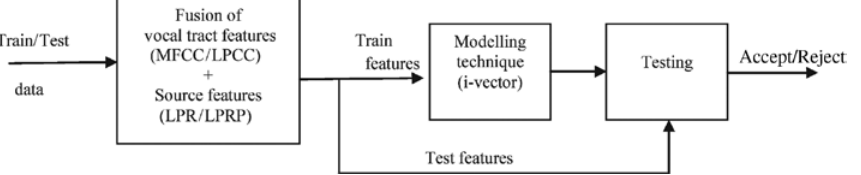
Figure 2: Block Diagram of Feature-Level